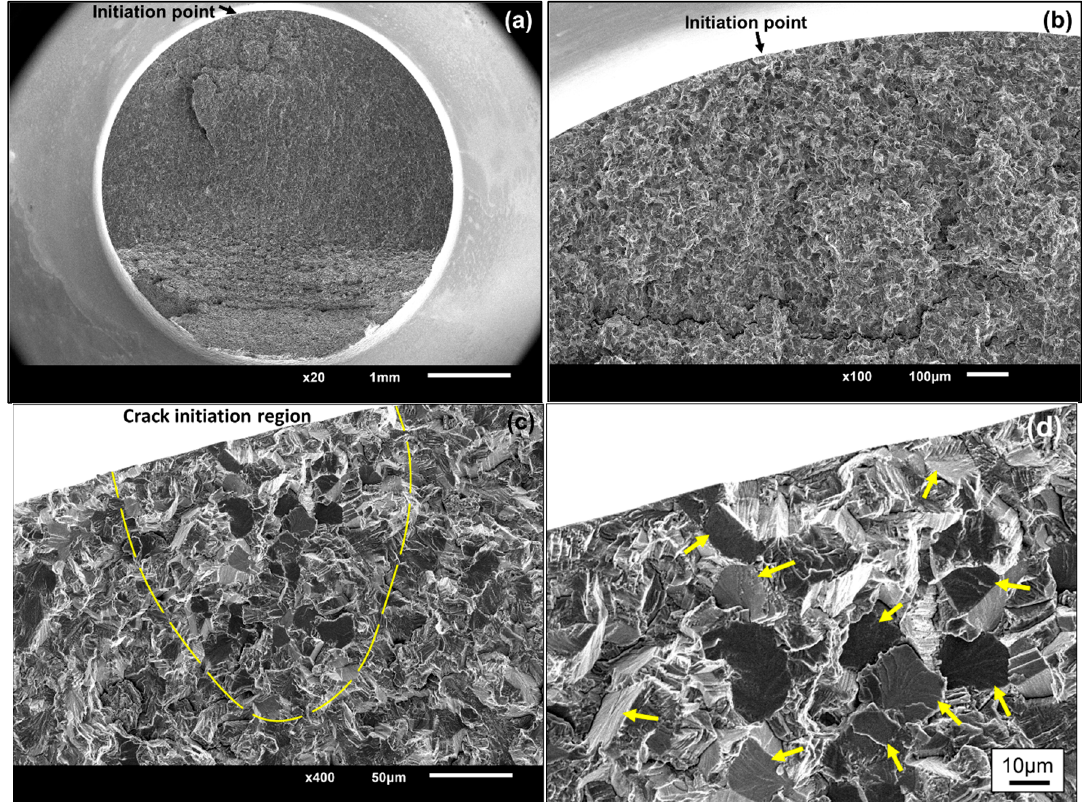
Figure 5. Typical fractography of single-point surface crack initiation with clear facet feature (notched specimen, R = 0.5, σ a = 140 MPa, N f = 6.048 × 10 7 cycles); ( a ) the whole fracture surface; ( b ) macro profile with crack initiation region and crack propagation region; ( c ) enlargement of crack initiation region recognized by the facet feature and separated by the dashed line; ( d ) enlargement of the facets, as pointed out by the arrows.